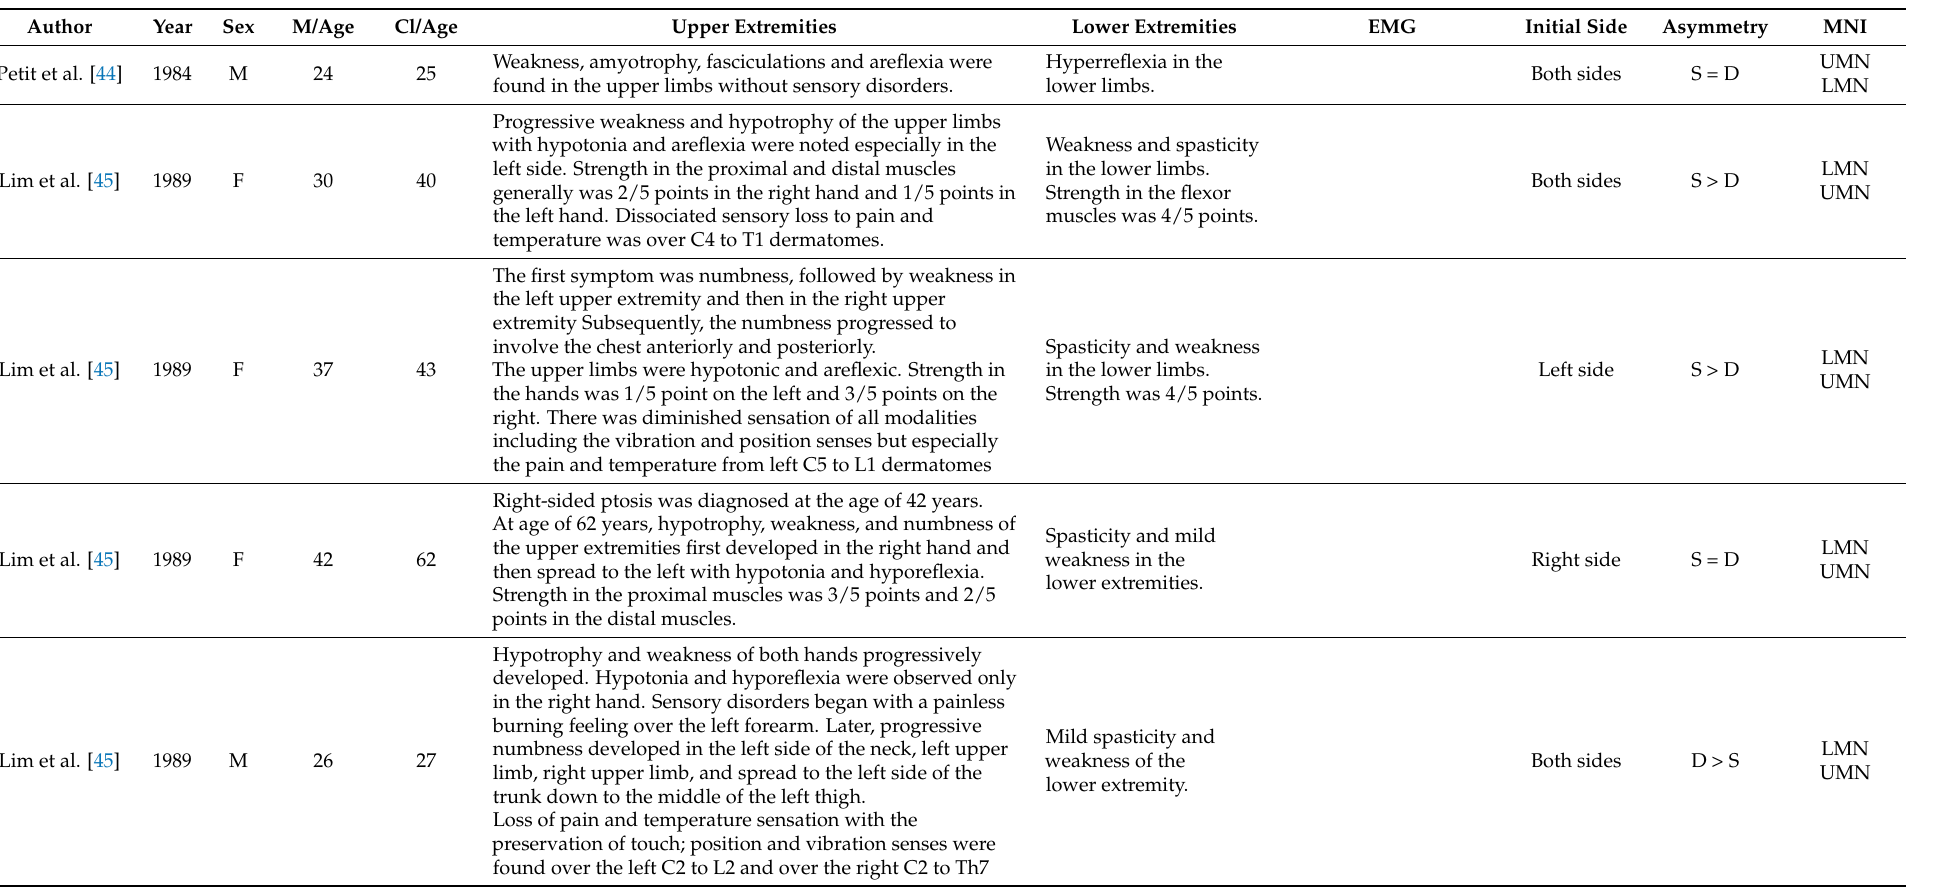
Table 3. Clinical cases of Syr-associated amyotrophic lateral sclerosis mimic syndrome in patients with Chiari malformation type 1 in the PubMed